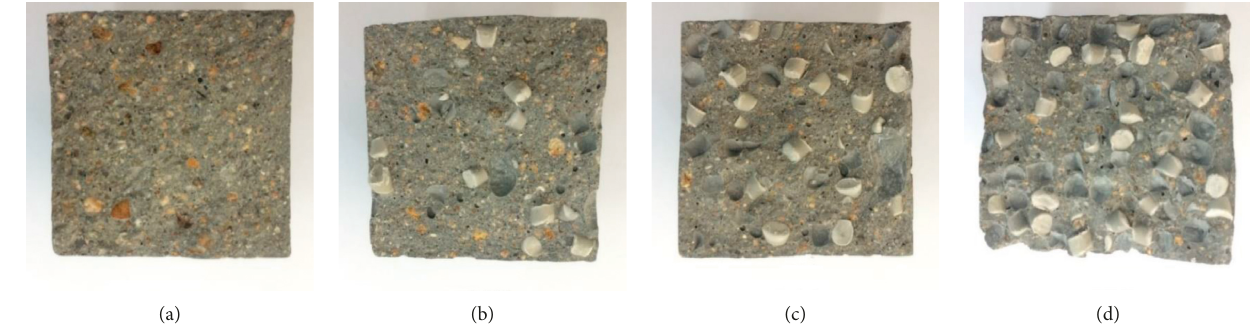
Figure 4: The photographs of mortar specimens’ section with different recycled PP plastic particles’ content: (a) PP0, (b) PN2, (c) PP4, and (d) PN6.